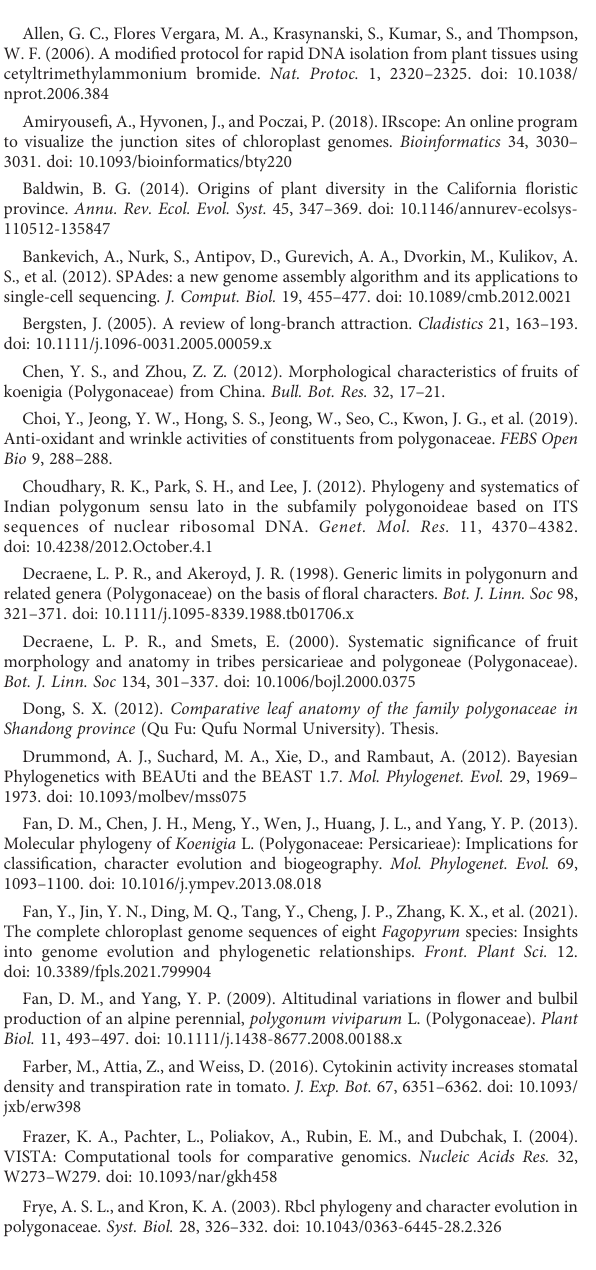
SUPPLEMENTARY FIGURE 2 Sequence alignment of Persicarieae plastomes using mVISTA. The position andtranscriptional directionof each gene areindicated by gray arrows. The vertical scale indicates the percentage of identity, ranging from 50 to 100%. The horizontal axis indicates the coordinates within the plastome. Genome regions are color-coded as exons, introns, and intergenic spacer (IGS). SUPPLEMENTARY FIGURE 3 Thenucleotidediversity(Pi)valuesofthePersicarieaeplastomes;Pivalues of coding genes and Pi values of IGS. The red arrows point to the 12 most highly variable loci.